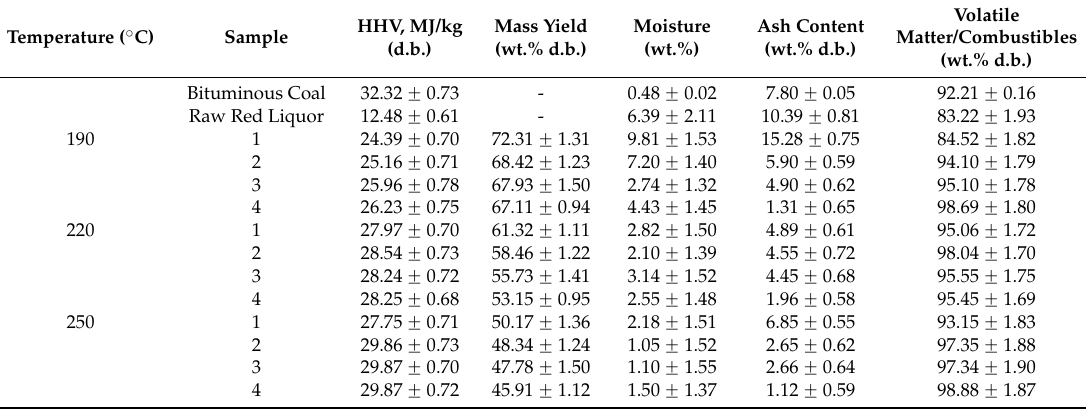
Table 2. Thermal Analysis, Yield and Energy Characterization of the Hydrochar